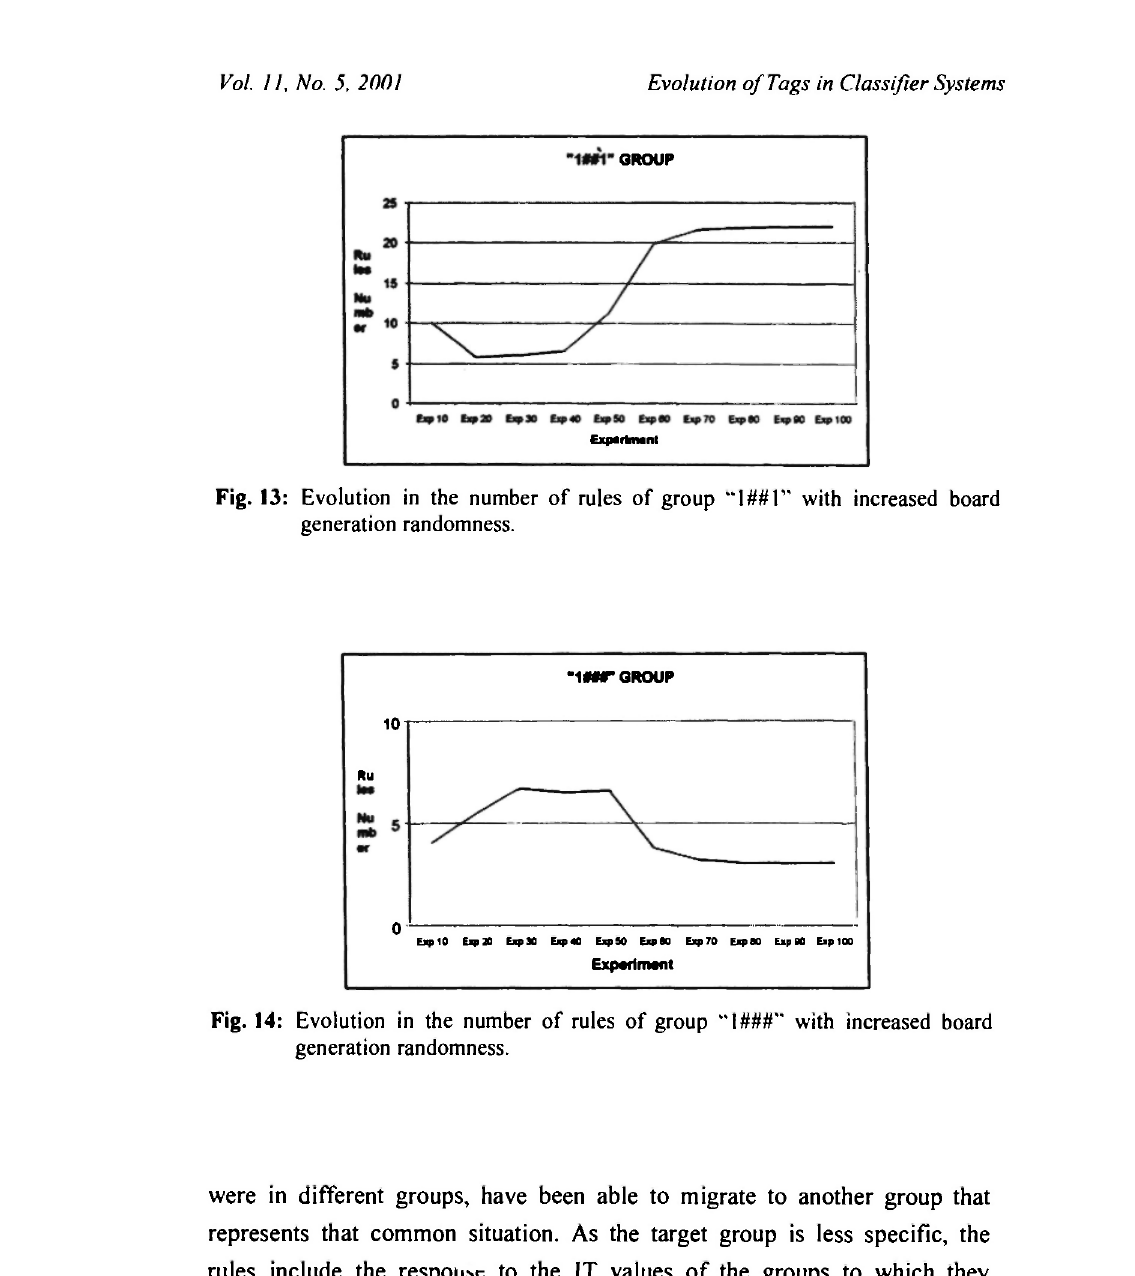
Fig. 14: Evolution in the number of rules of group "l###" with increased board generation